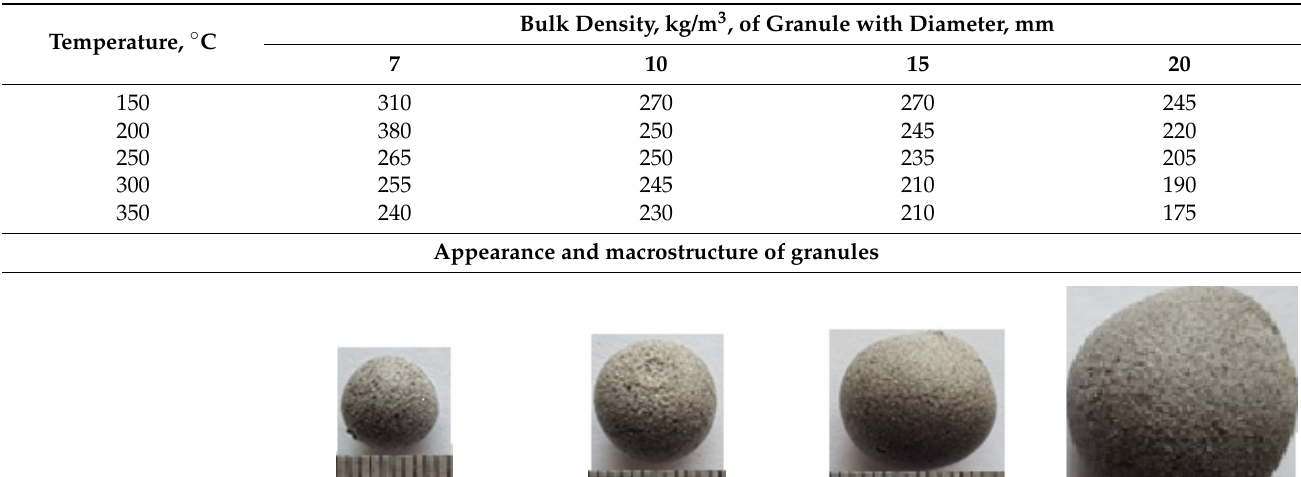
Table 5. Influence of firing temperature on the properties of granules of different sizes (mixture 10).